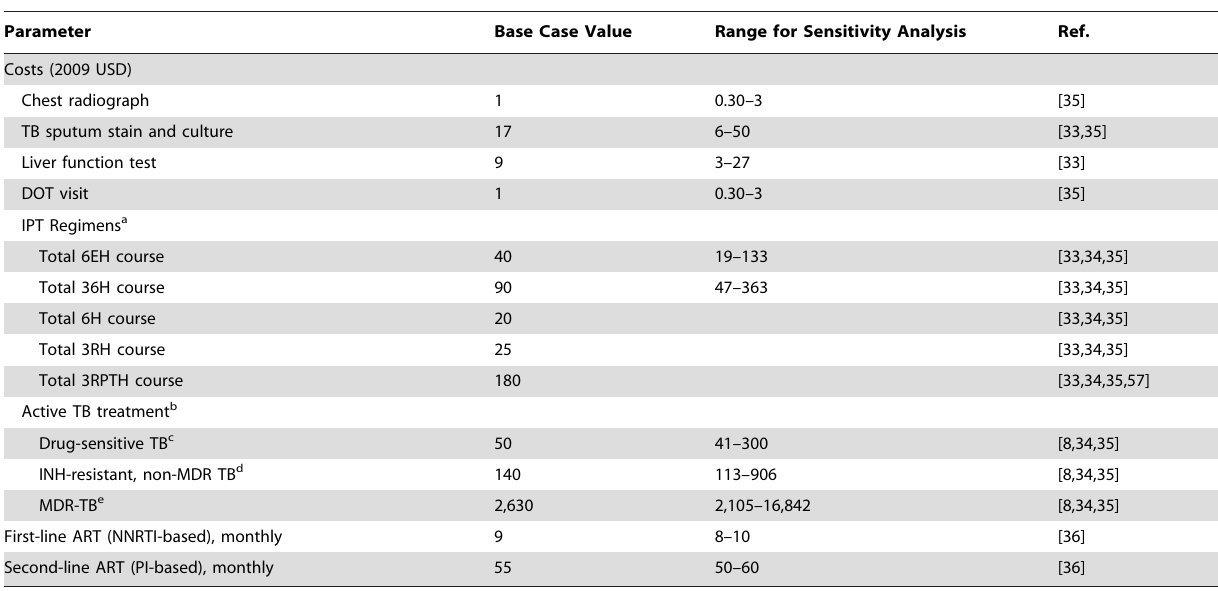
Table 3. Selected cost parameters.